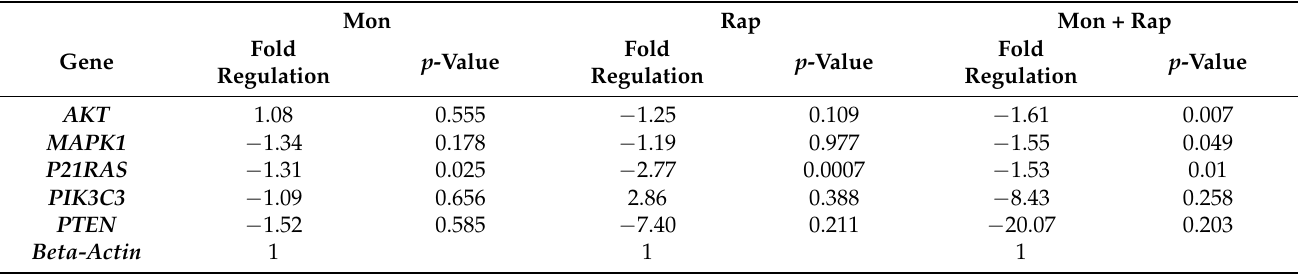
Table 2. mRNA expression changes of PI3K/AKT-pathway-related genes in mon, rap, and mon + rap treated SH-SY5Y cells compared to the control group ( p < 0.05).